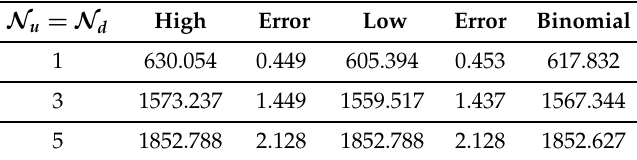
Table 3. Swing option values as a function of the number of exercise rights with a single underlying asset. Parameter values used are exercise volume of 60 units, S 0 = 40, b = 20, R = 4000, m = 5, and no usage penalty.